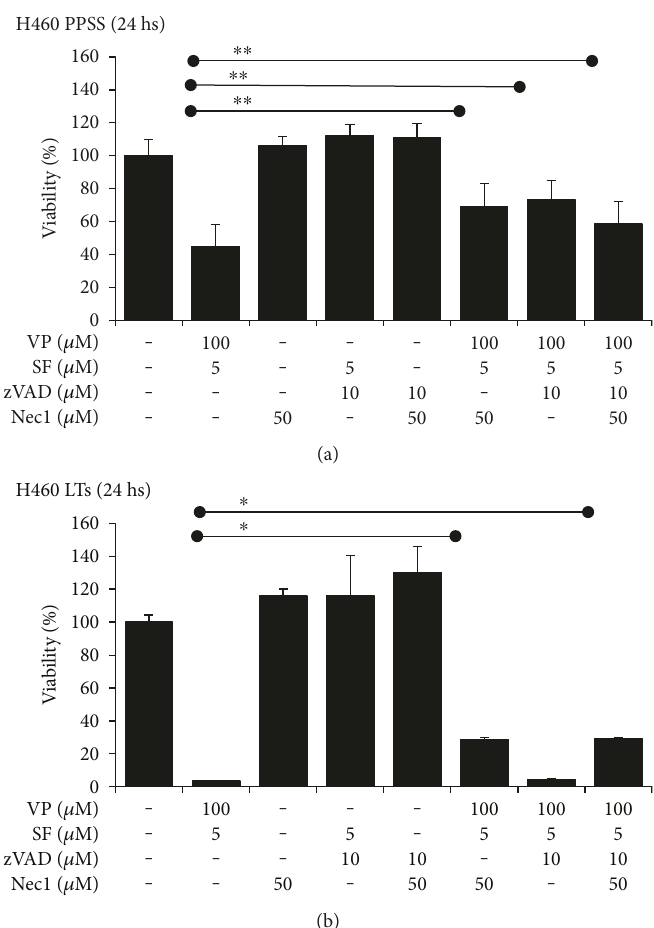
Figure 5: zVAD and Nec1 partially rescued the viability of cells. (a) Cells growing under PPSS for 8 – 10 days were incubated with the indicated concentrations of VP and SF alone or in the presence of zVAD or Nec1 for 24h. Cell viability was measured by the MTT assay. (b) Cells growing as FTS for 14 – 16 days were incubated with the indicated concentrations of VP and SF alone or in the presence of zVAD or Nec1 for 24h. Cell viability was measured by the CCK assay. Results ( X ± SD) are representative of two independent experiments performed in sextuplicate. ∗ and ∗∗ indicate P < 0 01 and P < 0 05 , respectively (ANOVA).